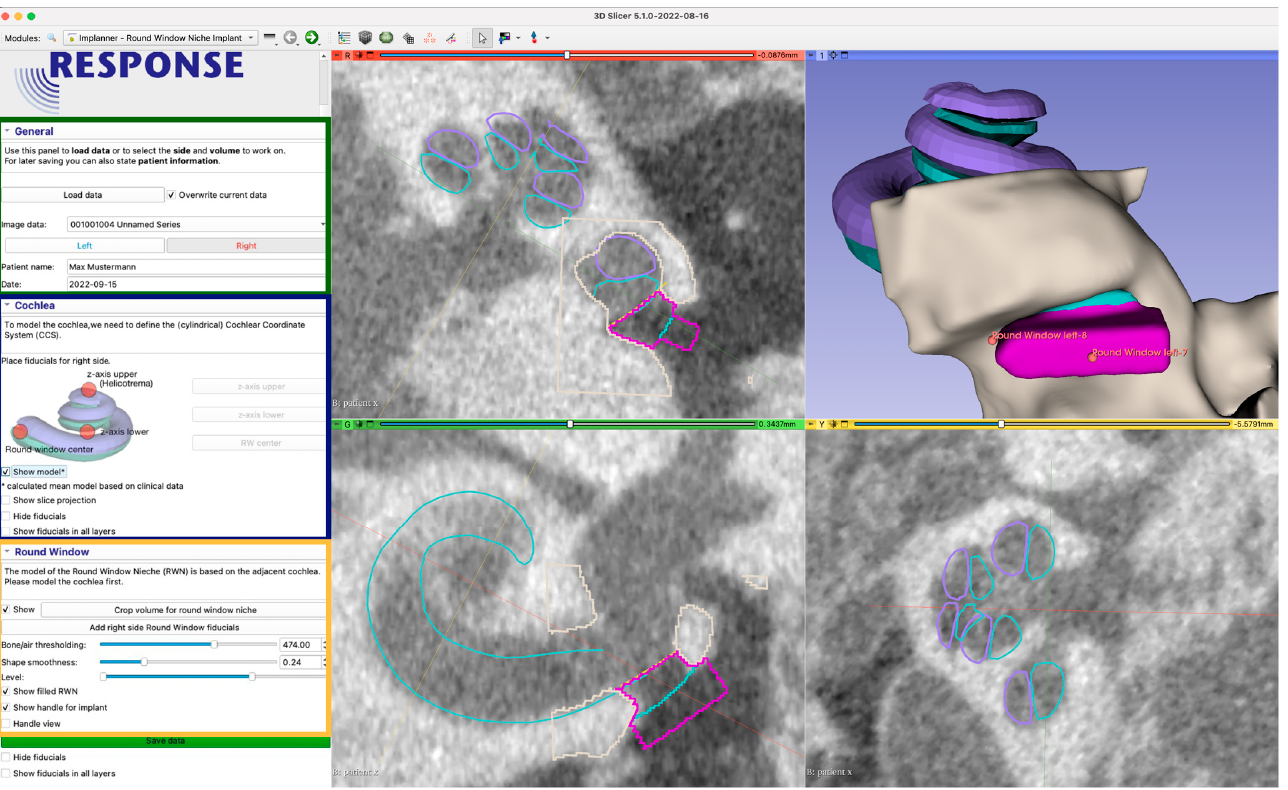
Figure 4. User interface of the developed 3D Slicer™ plugin. In the left side, the user is guided through the process (zoomed in image of the user interface on the left). The green section contains information for data management (patient id, date) and the working orientation (left/right). The blue section is used to place three initial fiducials (control points), for fitting the mean cochlea model. The third yellow section enables the user to add and adjust the adjacent RWN fiducials and to shape the resulting model. The dialog is also used to add a handle and to finally export the data for 3D printing. The right side shows three orthogonal image planes as well as a 3D-rendering of the segmented structures (beige/gray) and derived models. The views are used to interact with the medical image by achieving the accurate placement of control points. By placing the first three fiducials for the z-axis upper and lower points and the RW-center, a mean cochlea model consisting of the scala tympani (cyan) and the scala vestibuli (violet) is placed. The view also shows the model filling the RWN (also cyan) and the handle (pink) with additional fiducials to move and scale the